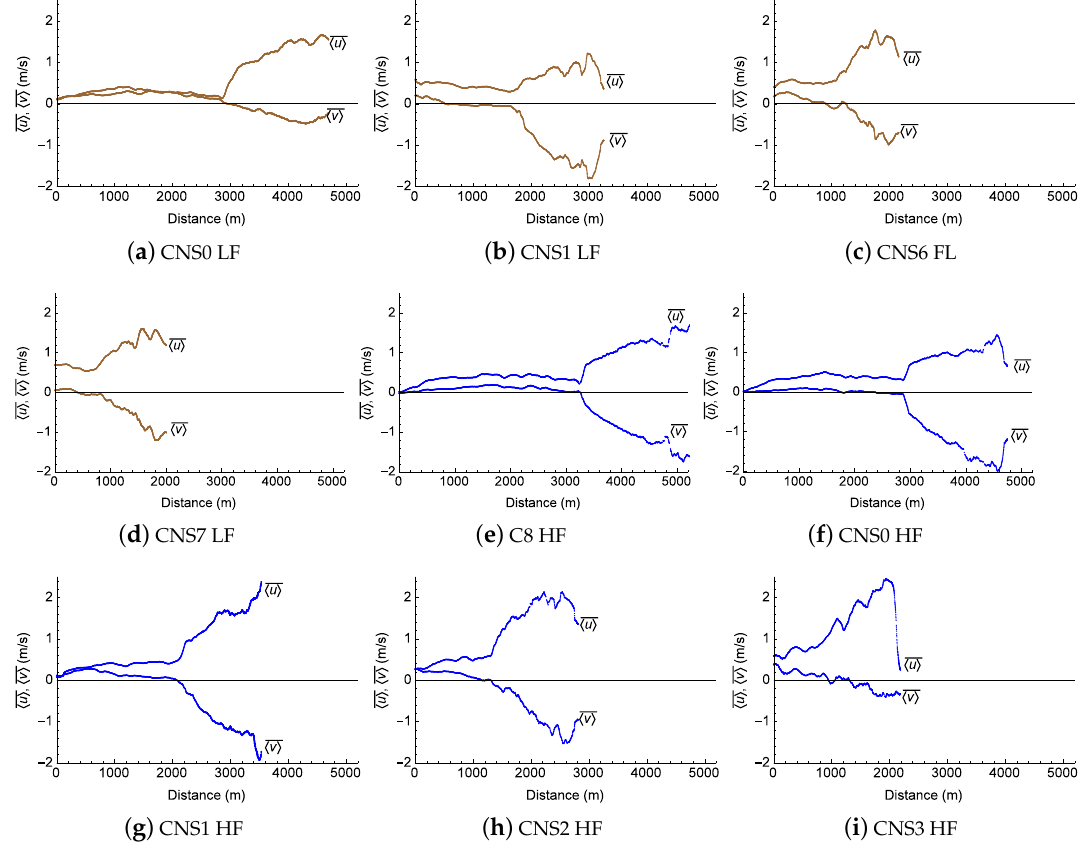
Figure 4. Velocity components (cid:104) u (cid:105) and (cid:104) v (cid:105) across the sampling transects. The brown and blue plots correspond to the relatively low and high flow campaigns,